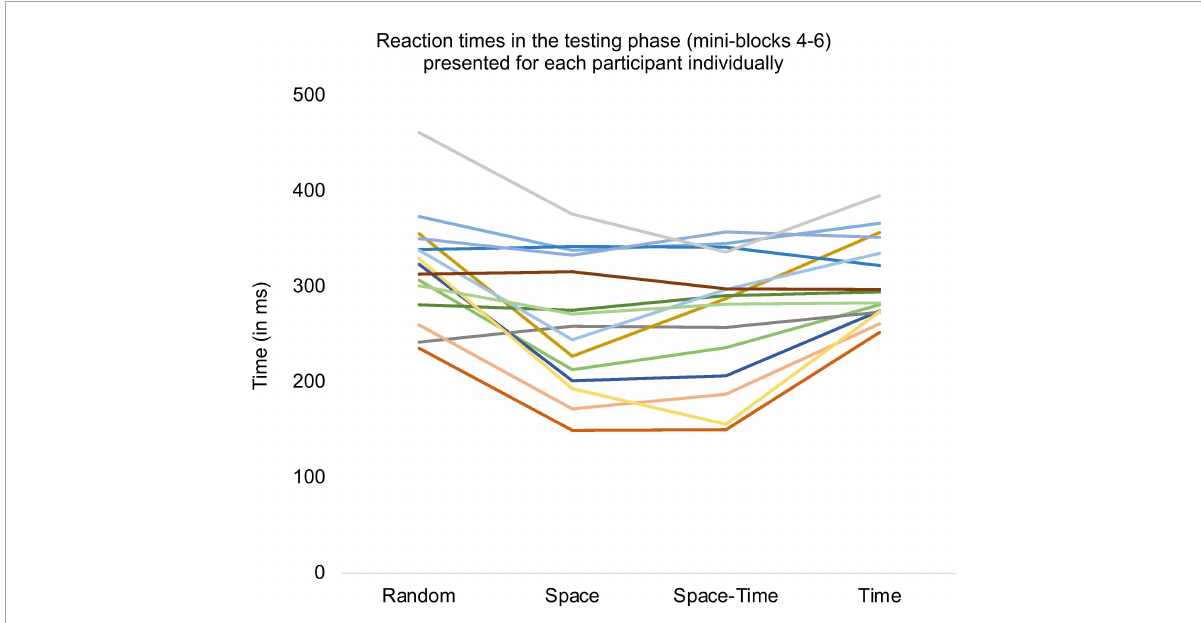
FIGURE7 Reaction times averaged for all trials from the testing phase and presented separately for each subject.